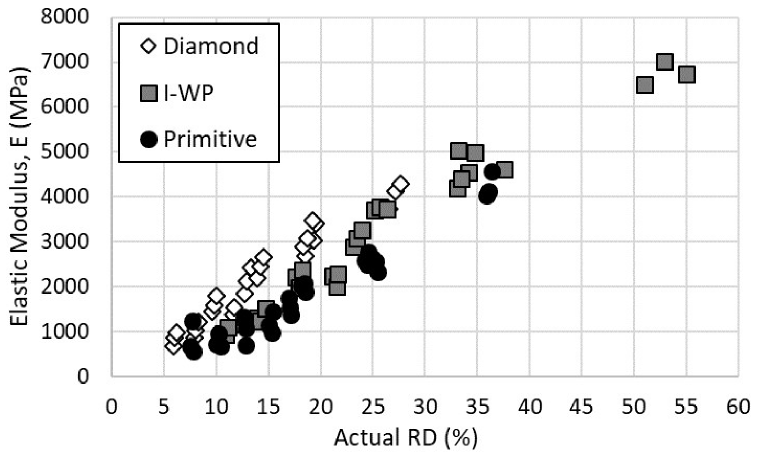
Figure 6. Modulus of elasticity versus actual relative density of lattice designs.